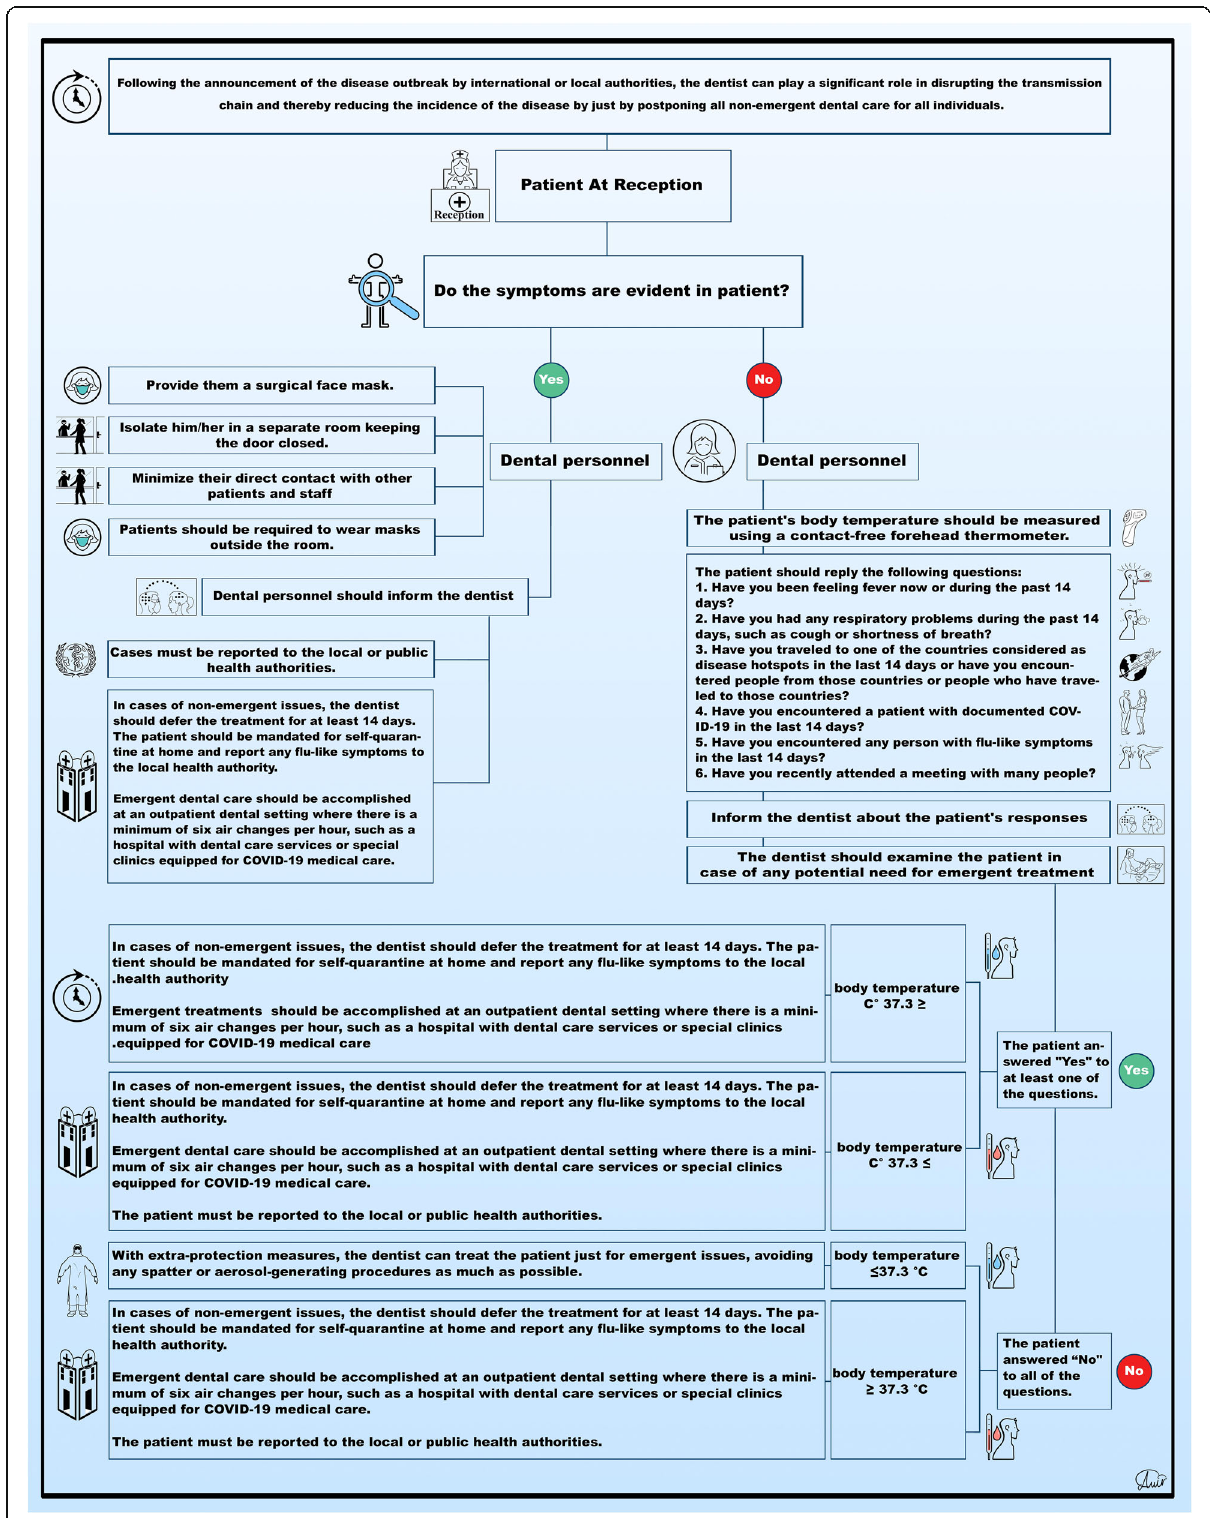
Fig. 2 Protocol for the management of patients during the Covid-19